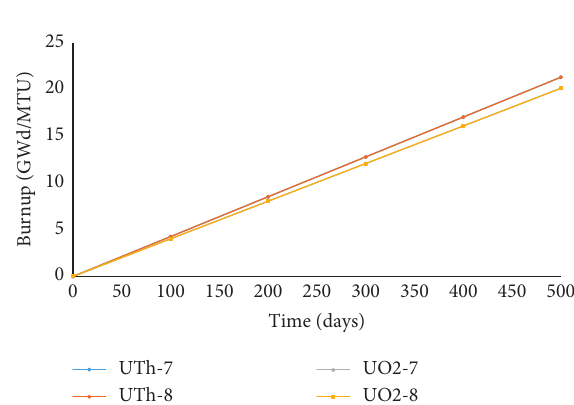
Figure 5: The change in the burnup over time for one-six